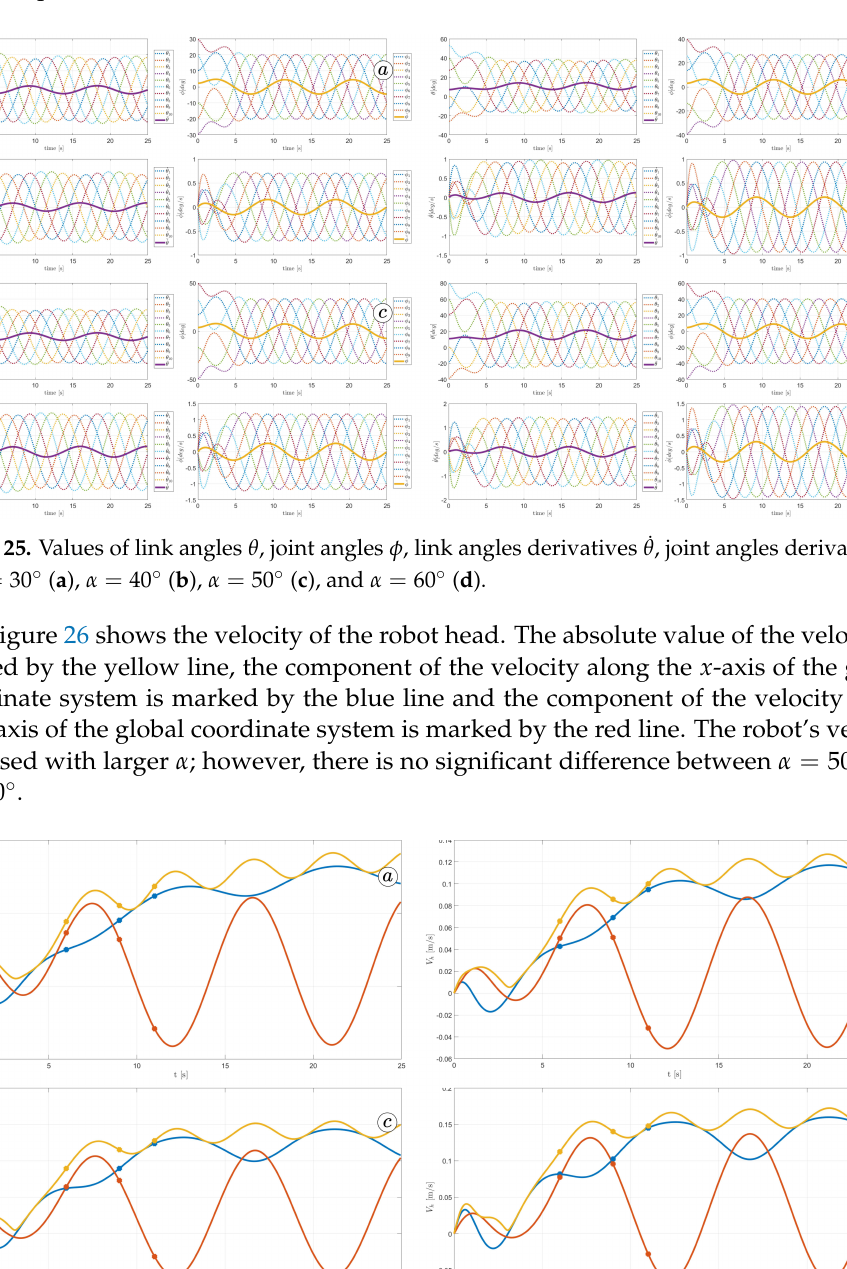
Figure 26. Velocity of the snake robot’s head for α = 30 ◦ ( a ), α = 40 ◦ ( b ), α = 50 ◦ ( c ), and α = 60 ◦ ( d ). Figure 27 shows the torques applied to the robot’s joints. They increased linearly with rising